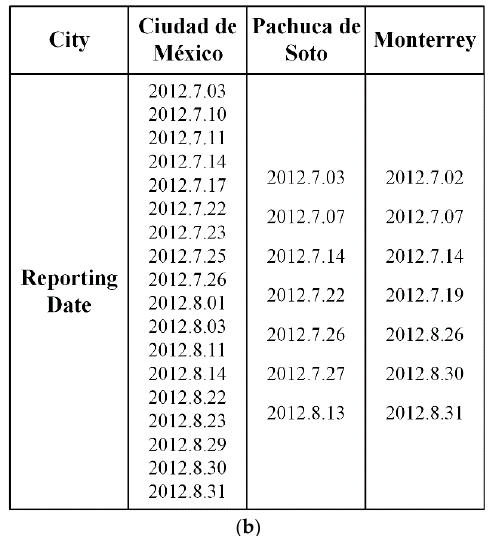
Figure 16. Three cities reporting numerous significant events. ( a ) geo-location of the three cities; ( b ) reporting dates of significant events for the three cities.